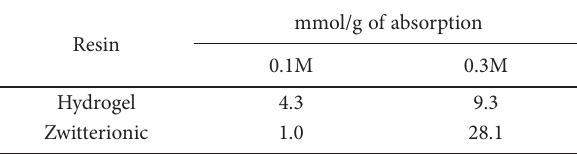
Table 4. Electrical conductivity results for the hydrogel polymer dry sample (weight 0.05 g) in 50 mL NaCl solution (with an average experimental error of about ± 0.05 mS/cm).